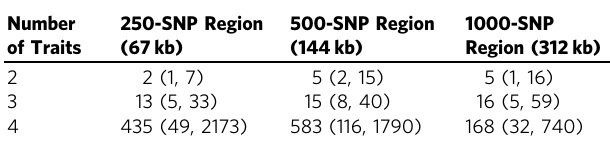
Table 2 Median fl ashfm running time (with second and third quartiles), in